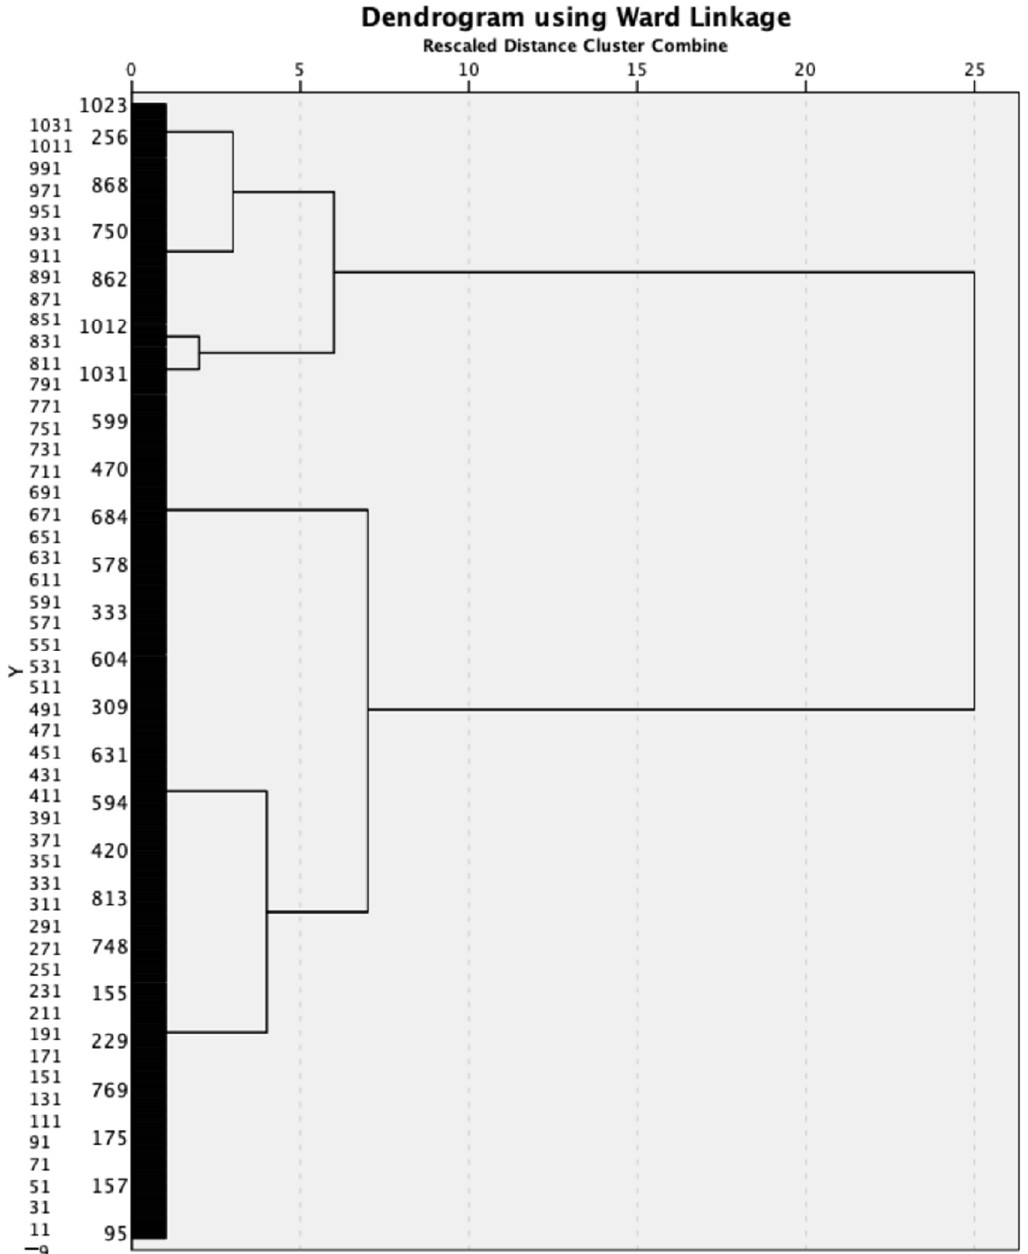
Figure 1. Dendrogram output using Ward Linkage to determine number of clusters.